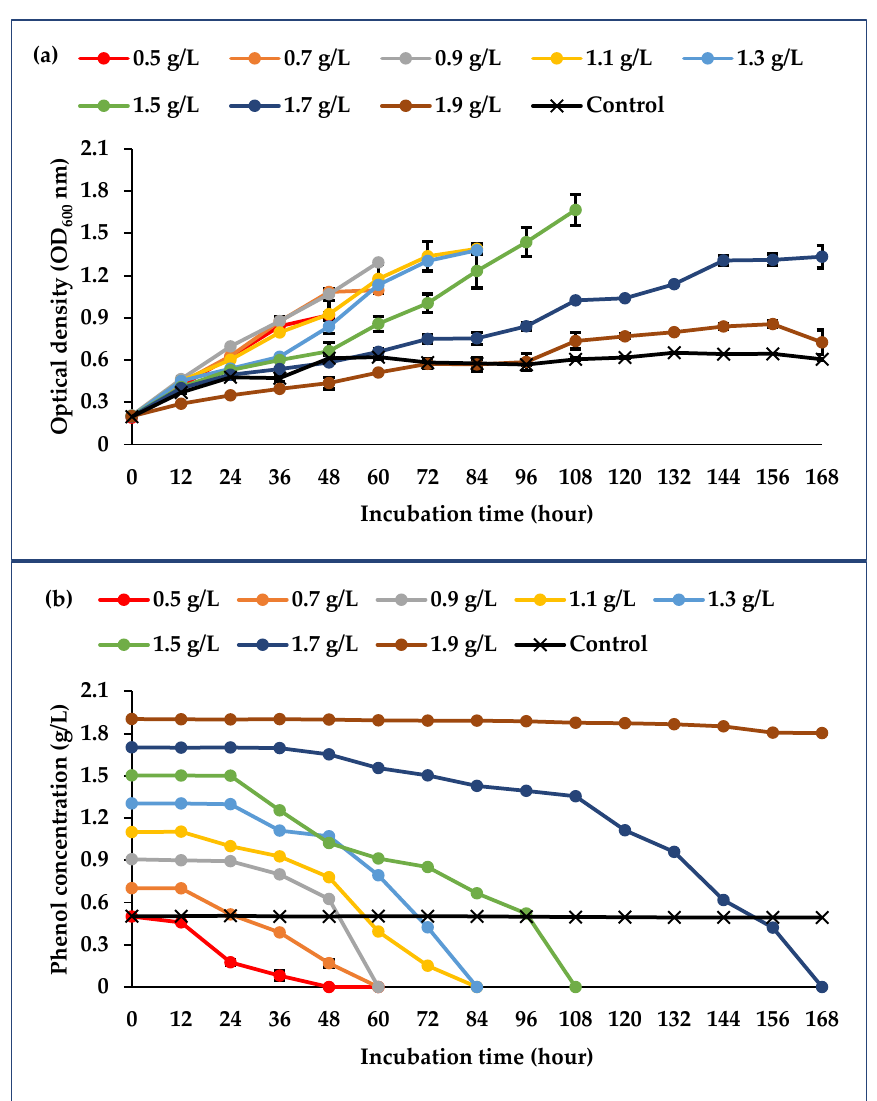
Figure 3 . ( a ) Bacterial growth and ( b ) degradation of different initial concentrations of phenol by the binary consortium under optimized conditions (0.40 g/L (NH 4 ) 2 SO 4 , 0.13 g/L NaCl, pH 7.25, 12.50°C). The control (cross mark) shows the initial phenol concentration in the absence of the bac- terial strain. Error bars represent the mean ± standard deviation of three replicates.